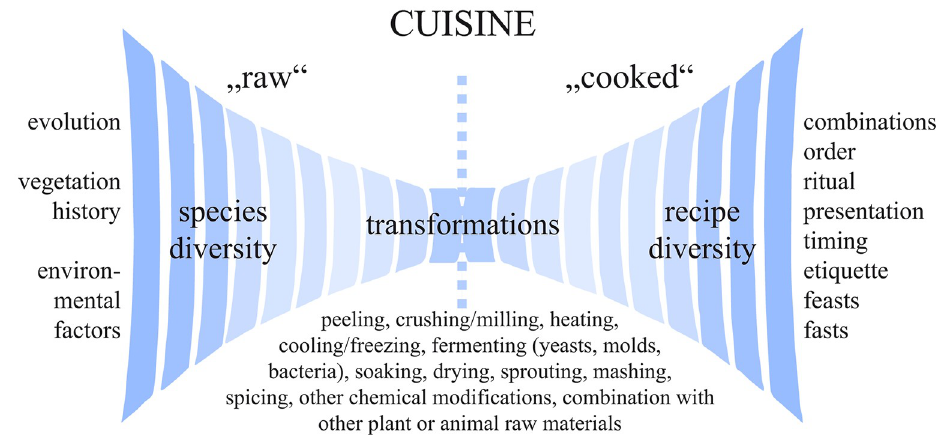
Fig 6. Cuisine , the art of cooking, illustrated as a space of possibilities. The transformations of natural, unchanged ("raw") plant components into culturally modified ("cooked") food is roughly inspired by Le´vi-Strauss’ [78] triangle culinaire ( cru – cuit – pourri ).While natural conditions (on the left side) influence the possible ingredients, it is cultural aspects (on the right side) on which their processing and consumption patterns depend. Image: OeAW-OeAI/A. G. Heiss, modified from Katz and Voigt